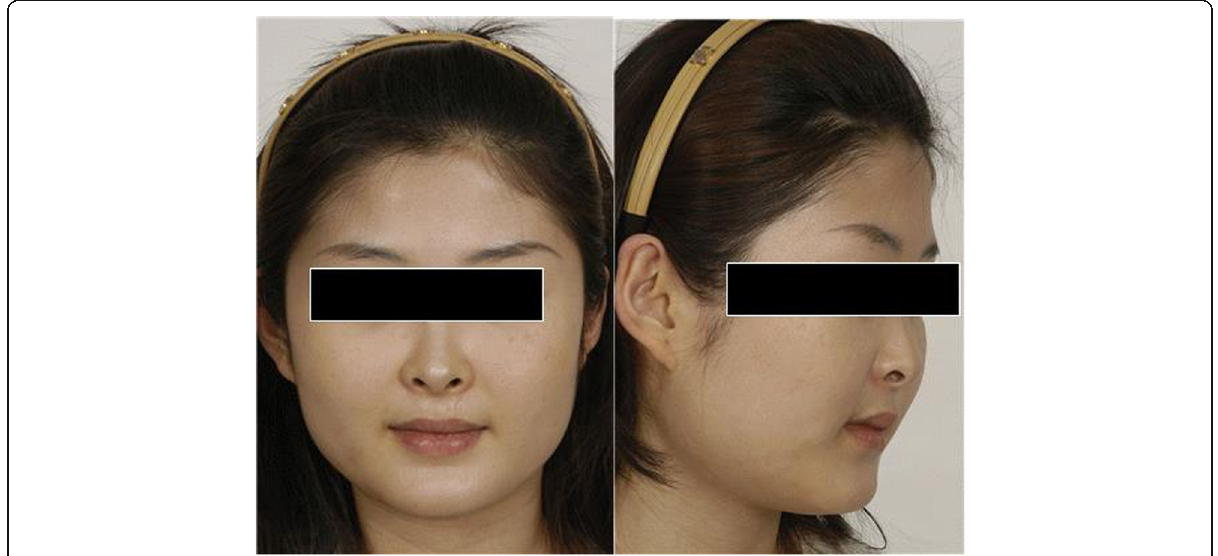
Fig. 14 Type I. muscular type. Hypertrophy of masseteric muscles is prominent, improvement is expected after botulinum toxin A